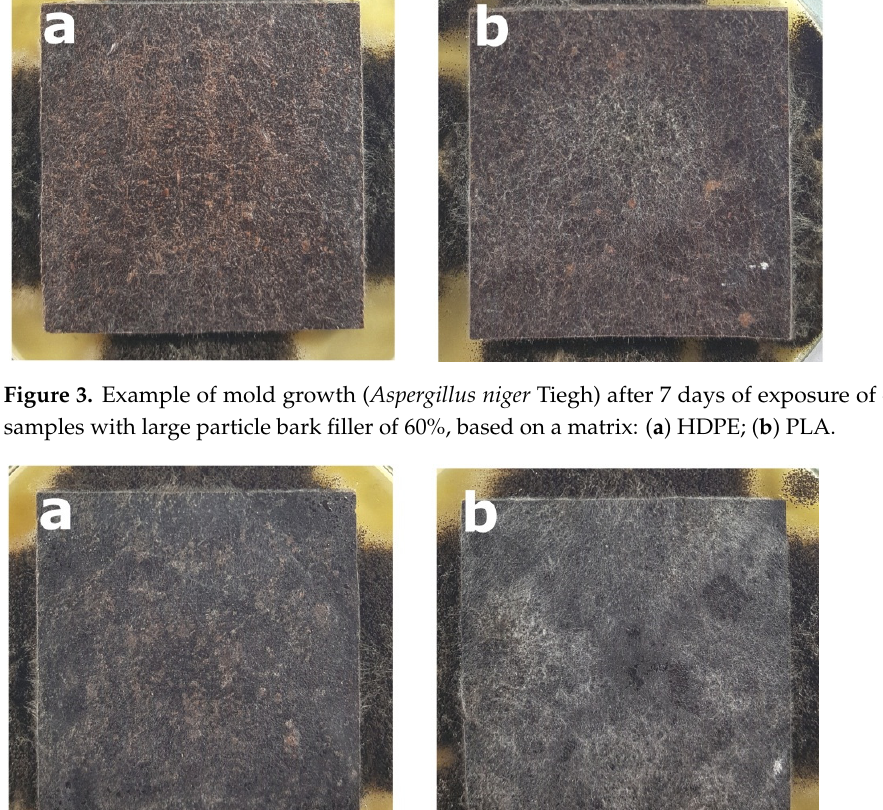
Figure 5. Example of mold growth ( Aspergillus niger Tiegh) after 7 days of exposure of composite samples with large particle sawdust filler of 60%, based on a matrix: ( a ) HDPE; ( b ) PLA. Application of the additives had a significant effect on the mold growth on both, PLA and HDPE composites (Figures 1a,d, 2a,d, 8 and 9). Irrespectively to the type of filler, the additives increased the rate of mold growth. It is worth adding here that the porosity of the composites in most cases (except for the composite based on polyethylene filled with small bark) generally decreased (Figure 10).